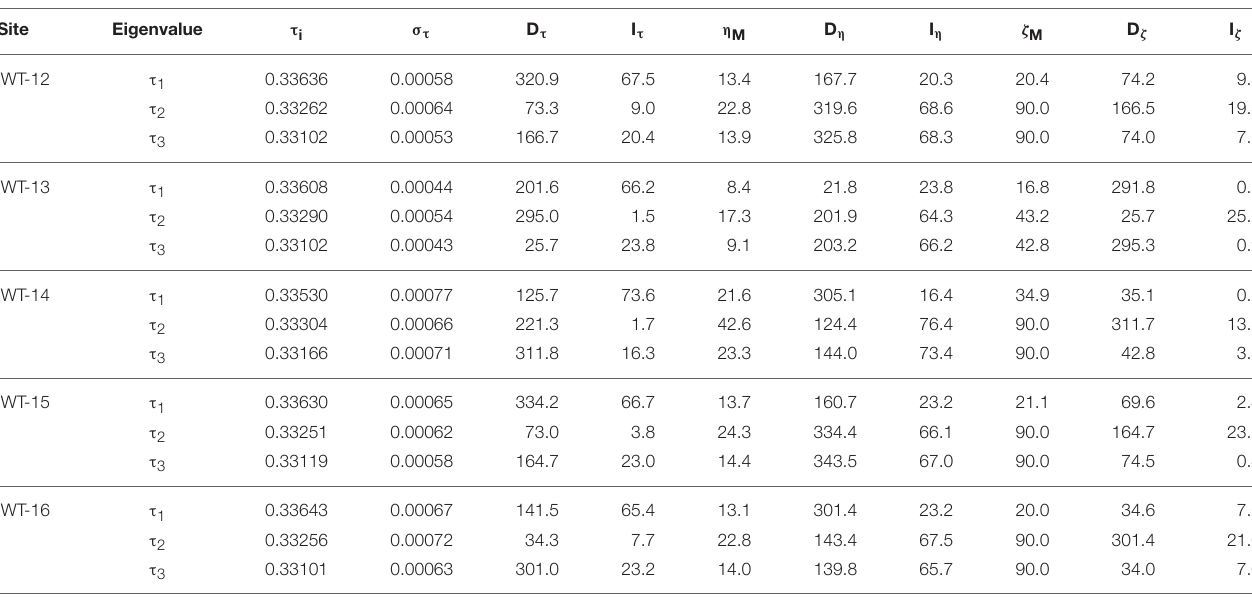
TABLE 3 | Site-mean AMS statistics of the intrusive welded tuff (IWT).